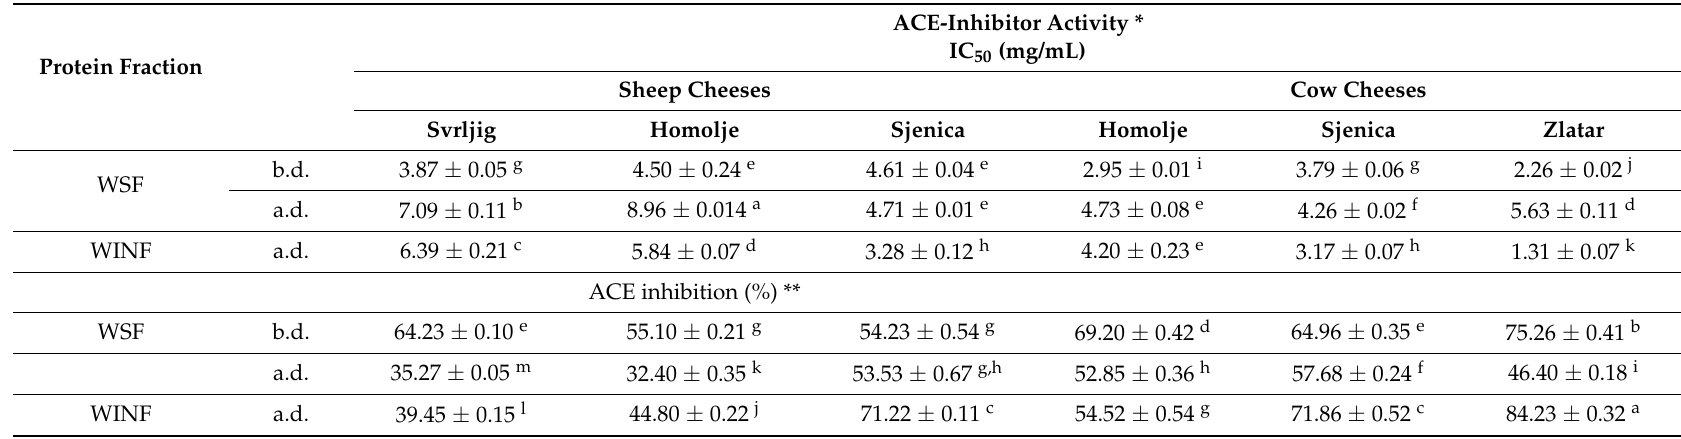
Table 3. The angiotensin-converting enyzme-inhibitory (ACE-inhibitory) activity of protein fractions of traditional Serbian white cheeses *.